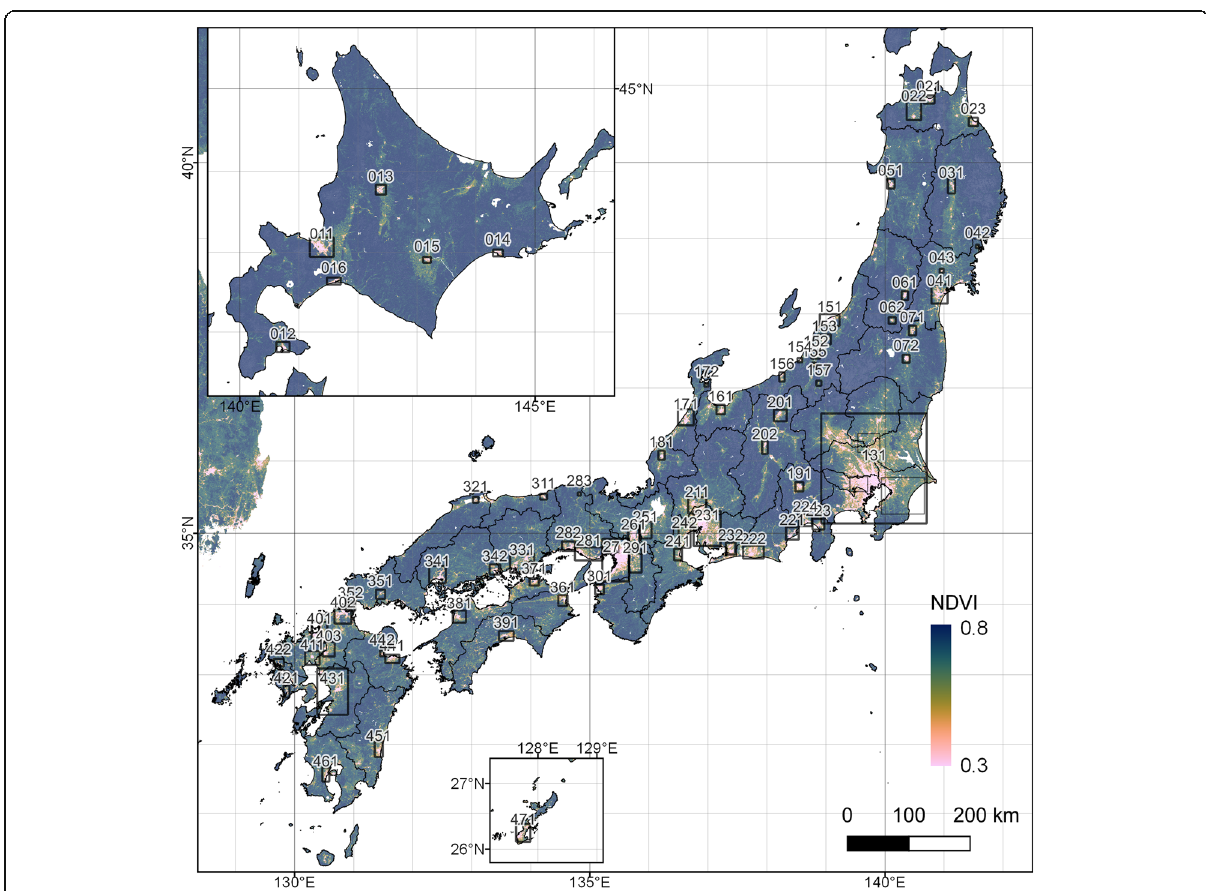
Fig. 2 A map of the clipped urban areas. Background colors denote NDVI in August